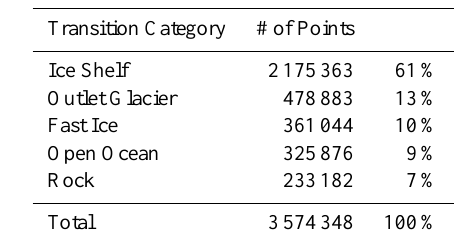
Table 1. Distribution of Antarctic Ice Sheet Grounded Ice Bound- ary